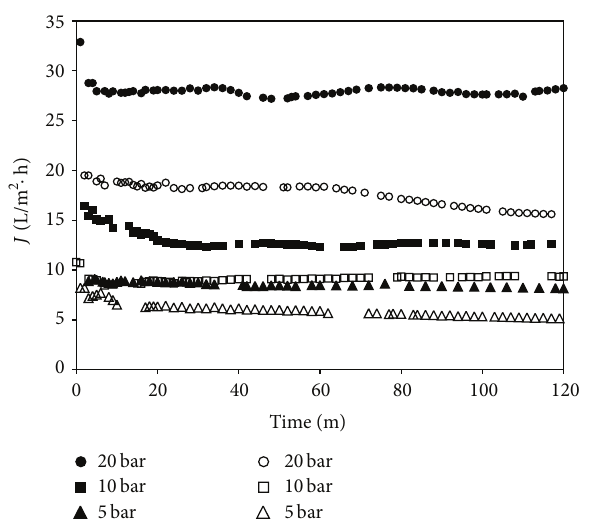
Figure 3: Permeate flux ( 𝐽 ) as a function of time during the recovery ethanol experiences to Δ𝑃 5–20 bar and 24 ∘ C (empty symbols) and 35 ∘ C (filled symbols).